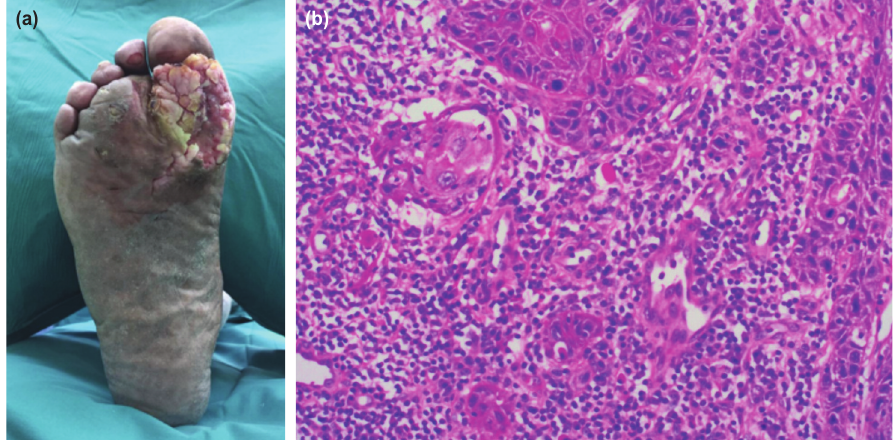
(a) Case 2 on secondary presentation showing a large 7 x 5cm exophytic ulcer over the base of the first metatarsal-phalangeal Fig. 3: joint (MTPJ) extending into first and second webspace. (b) Histology section showing infiltrating nests and islands of well differentiated squamous cell carcinoma, accompanied by